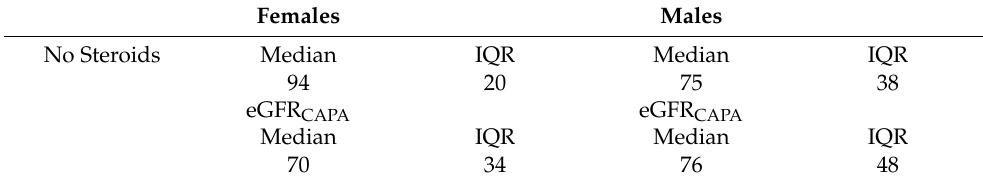
Table 3. Cont. Females Males No Steroids Median IQR Median IQR 94 20 eGFR